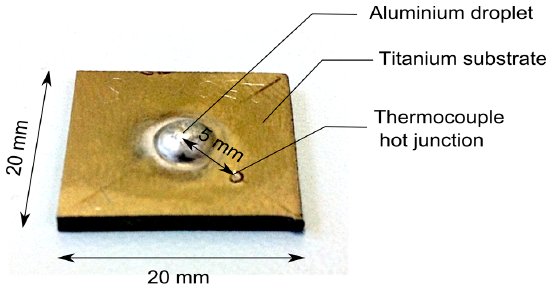
Figure 7. Experimental configuration.